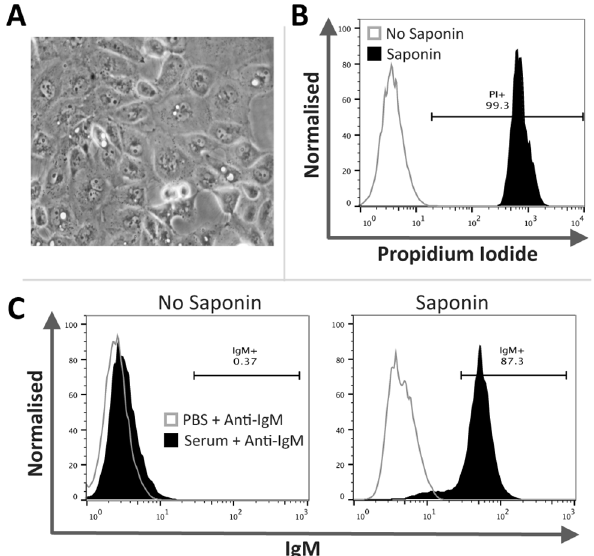
Fig 5. IgM binds to permeable human proximal tubule epithelial (HK-2) cells. Non-apoptotic HK-2 cells ( A ) were permeabilised with saponin prior to incubation with human serum (as a source of IgM).